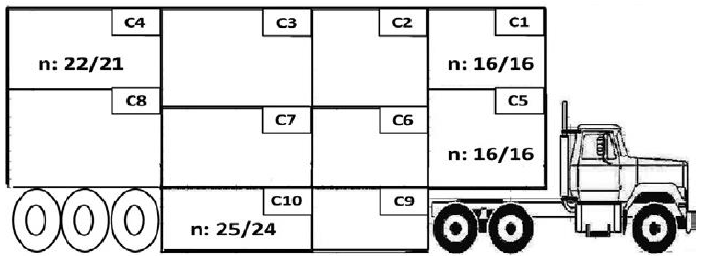
Figure 1. Compartment position inside the pot-belly trailer and distribution of pigs in the selected compartments in summer/winter.